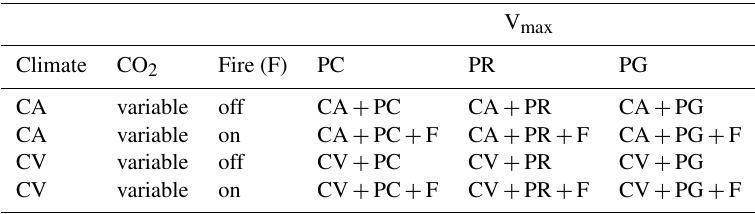
Table 1. Twelve simulation treatments evaluated by the INLAND model for the Amazon–Cerrado transition zone. CA, monthly clima- tological average, 1961–1990. CV, monthly climate data, 1948–2008. Nutrient limitation on V max : PC, no P limitation ( V max = 65µmol